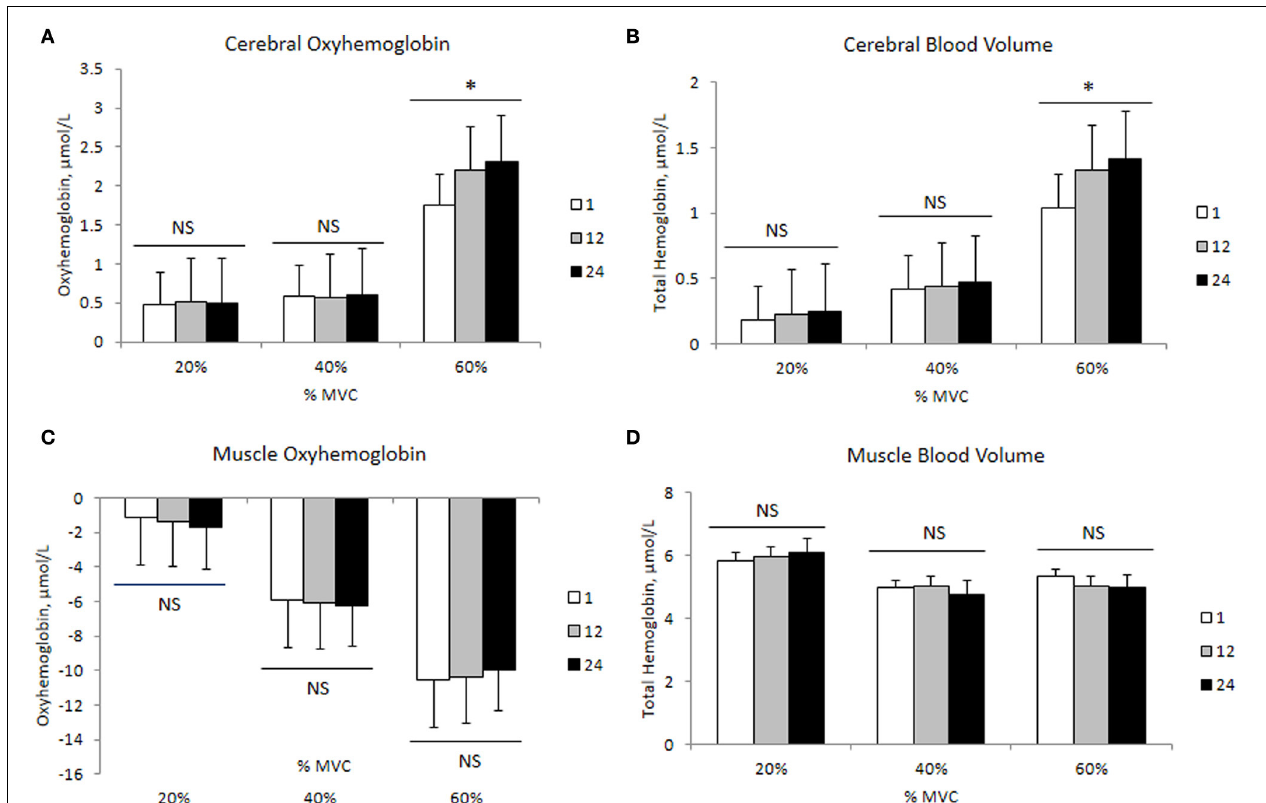
FIGURE 4 | Cerebral and muscle hemodynamic changes during 24 intermittent isometric contractions of the biceps brachii at three different intensities. ∗ Indicates P < 0 .